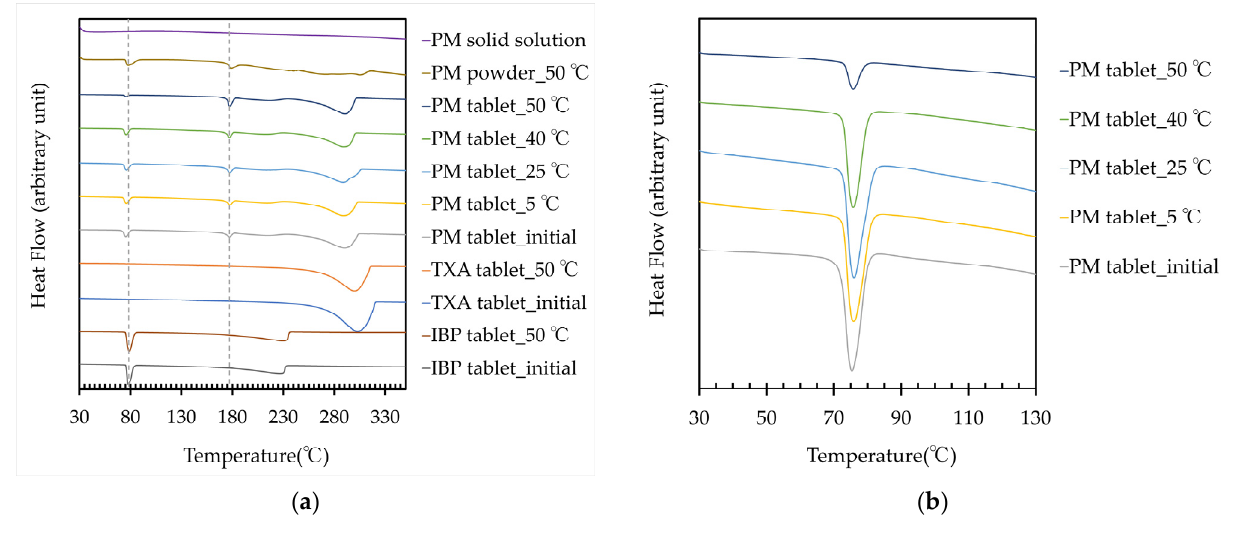
Figure 4. ( a ) Thermograms of the IBP, TXA, and PM tablets before and after storage for 60 days, PM powder, and PM solid solution; ( b ) Thermogram of the PM tablet at approximately 75 °C, before and after storage for 60 days. Table 1. Endothermic temperatures and energy amount associated with IBP and newly formed complexes, before and after storage for 60 days, and PM solid solution.